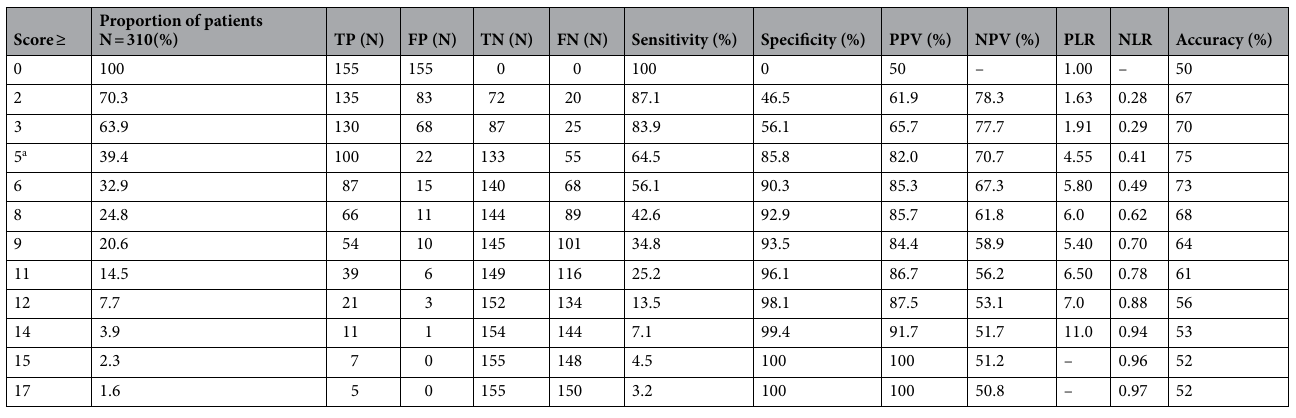
Table 6. Risk score performance characteristics for carbapenem-resistant Enterobacterales acquisition at different breakpoints FN False negative, FP false positive, NLR negative likelihood ratio, NPV